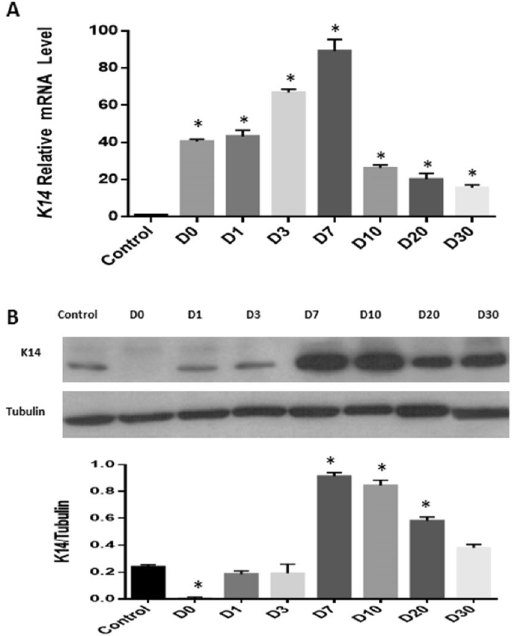
Figure 3. K14 level changes in lacrimal glands after ligation-induced injury. RT-qPCR showed that K14 gene expression dramatically increased after main excretory duct reopening on days 0–30 (( A) * P < 0.05). Western blot analysis ( B ) demonstrated K14 expression level change in tissues post-ligation